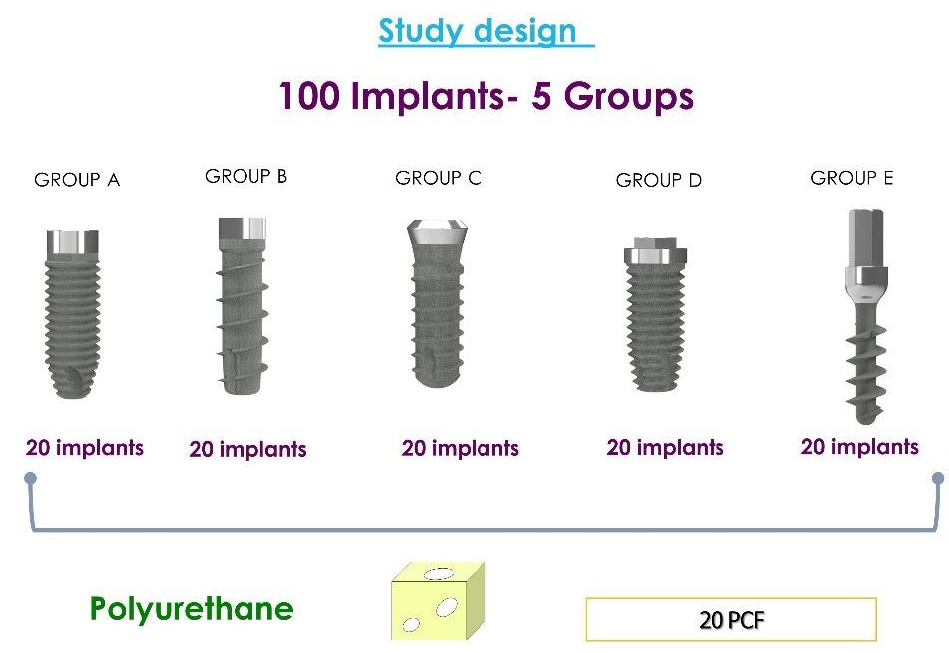
Figure 6. A graphical representation of the study design model.